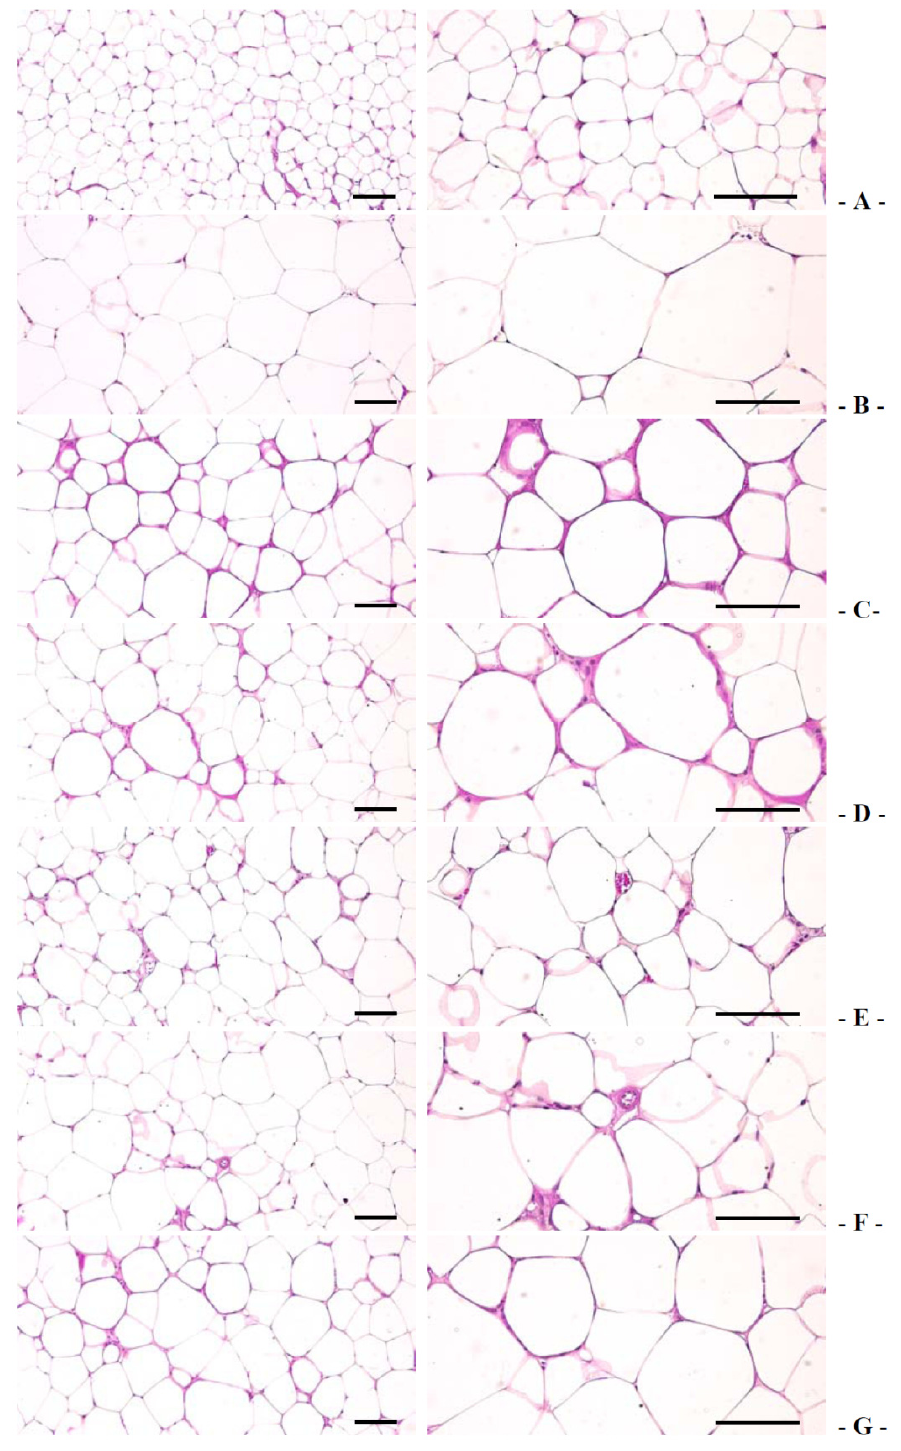
Figure 3. Representative histological images of the adipocytes, taken from intact normoglycemic or db/db mice periovarian fat pads. ( A ) Intact control mouse; ( B ) db control mouse; ( C ) metformin 250 mg/kg treated db mouse; ( D ) GT 400 mg/kg treated db mouse; ( E ) fGT 400 mg/kg treated db mouse; ( F ) fGT 200 mg/kg treated db mouse; ( G ) fGT 100 mg/kg treated db mouse. GT, Green tea aqueous lyophilized extracts; fGT, Aquilariae Lignum-fermented green tea aqueous lyophilized extracts. All Hematoxylin and Eosin stain. Scale bars = 80